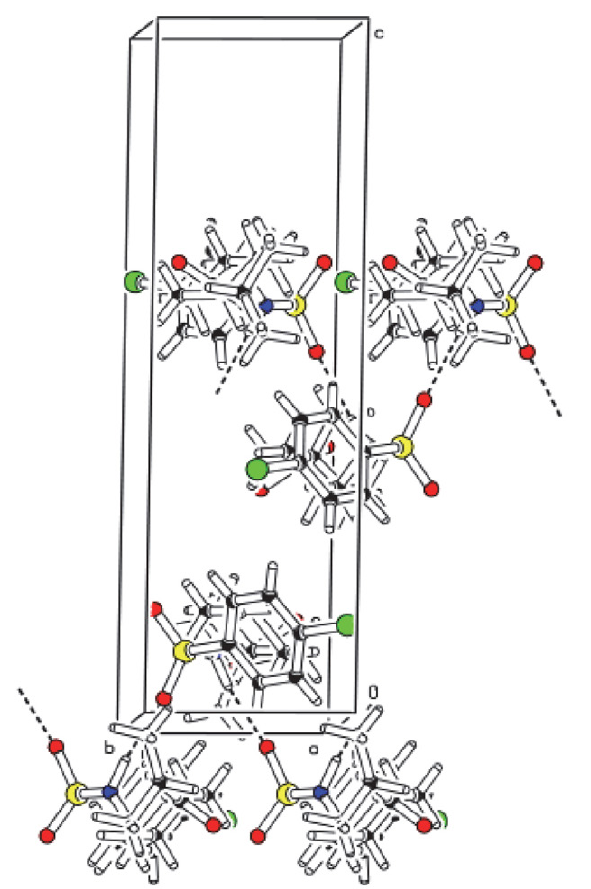
Figure 2. A unit cell view for 3 showing the intermolecular hydro- gen bonding and formation of long chains along b -axis.